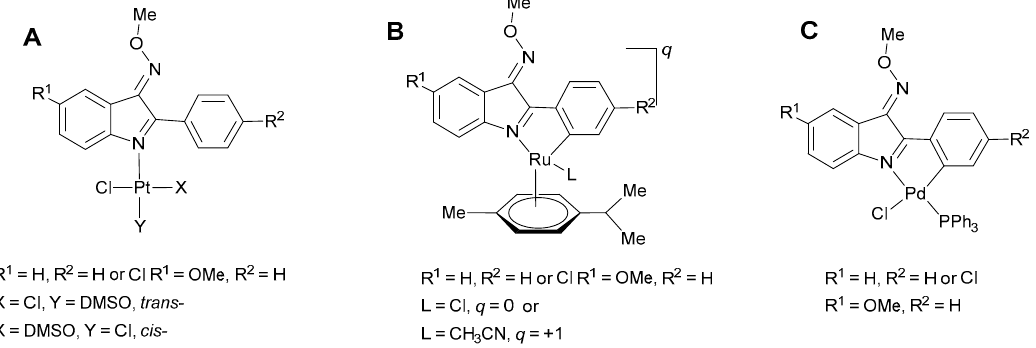
Figure 1. Three di ff erent types of compounds containing Pt(II) ( A ), Ru(II) ( B ) or Pd(II) ( C ) Figure 1. Three different types of compounds containing Pt(II) ( A ), Ru(II) ( B ) or Pd(II) ( C ) and 3- methoxyimino-2-susbtituted-3 H- indoles as ligands [21–23].